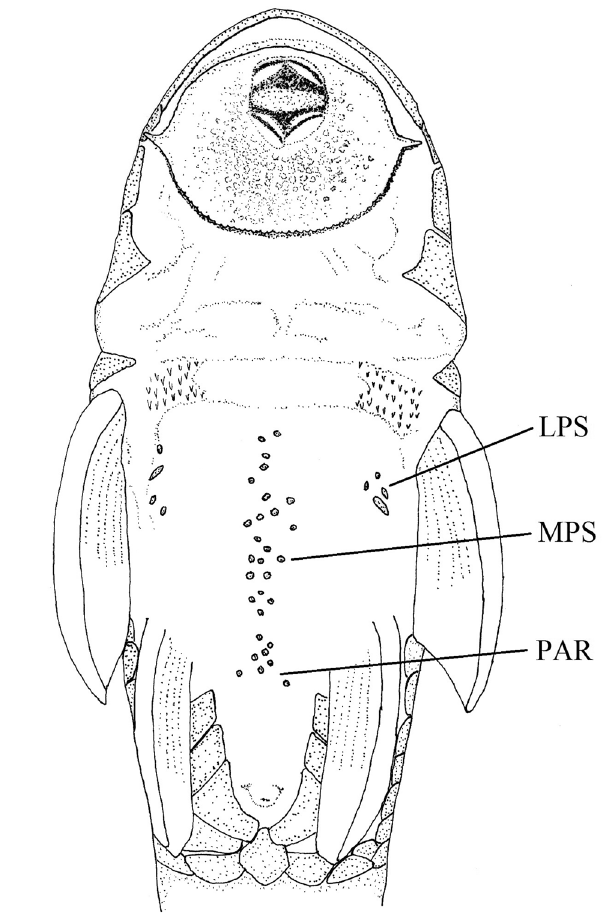
Fig. 3. Ventral view of abdominal region showing the lateral plates and preanal platelets in Parotocinclus seridoensis , UFRN 005, 37.0 mm SL, female . Abbreviations: LPS, lateral plate series; MPS, median plate series; PAR, preanal region.